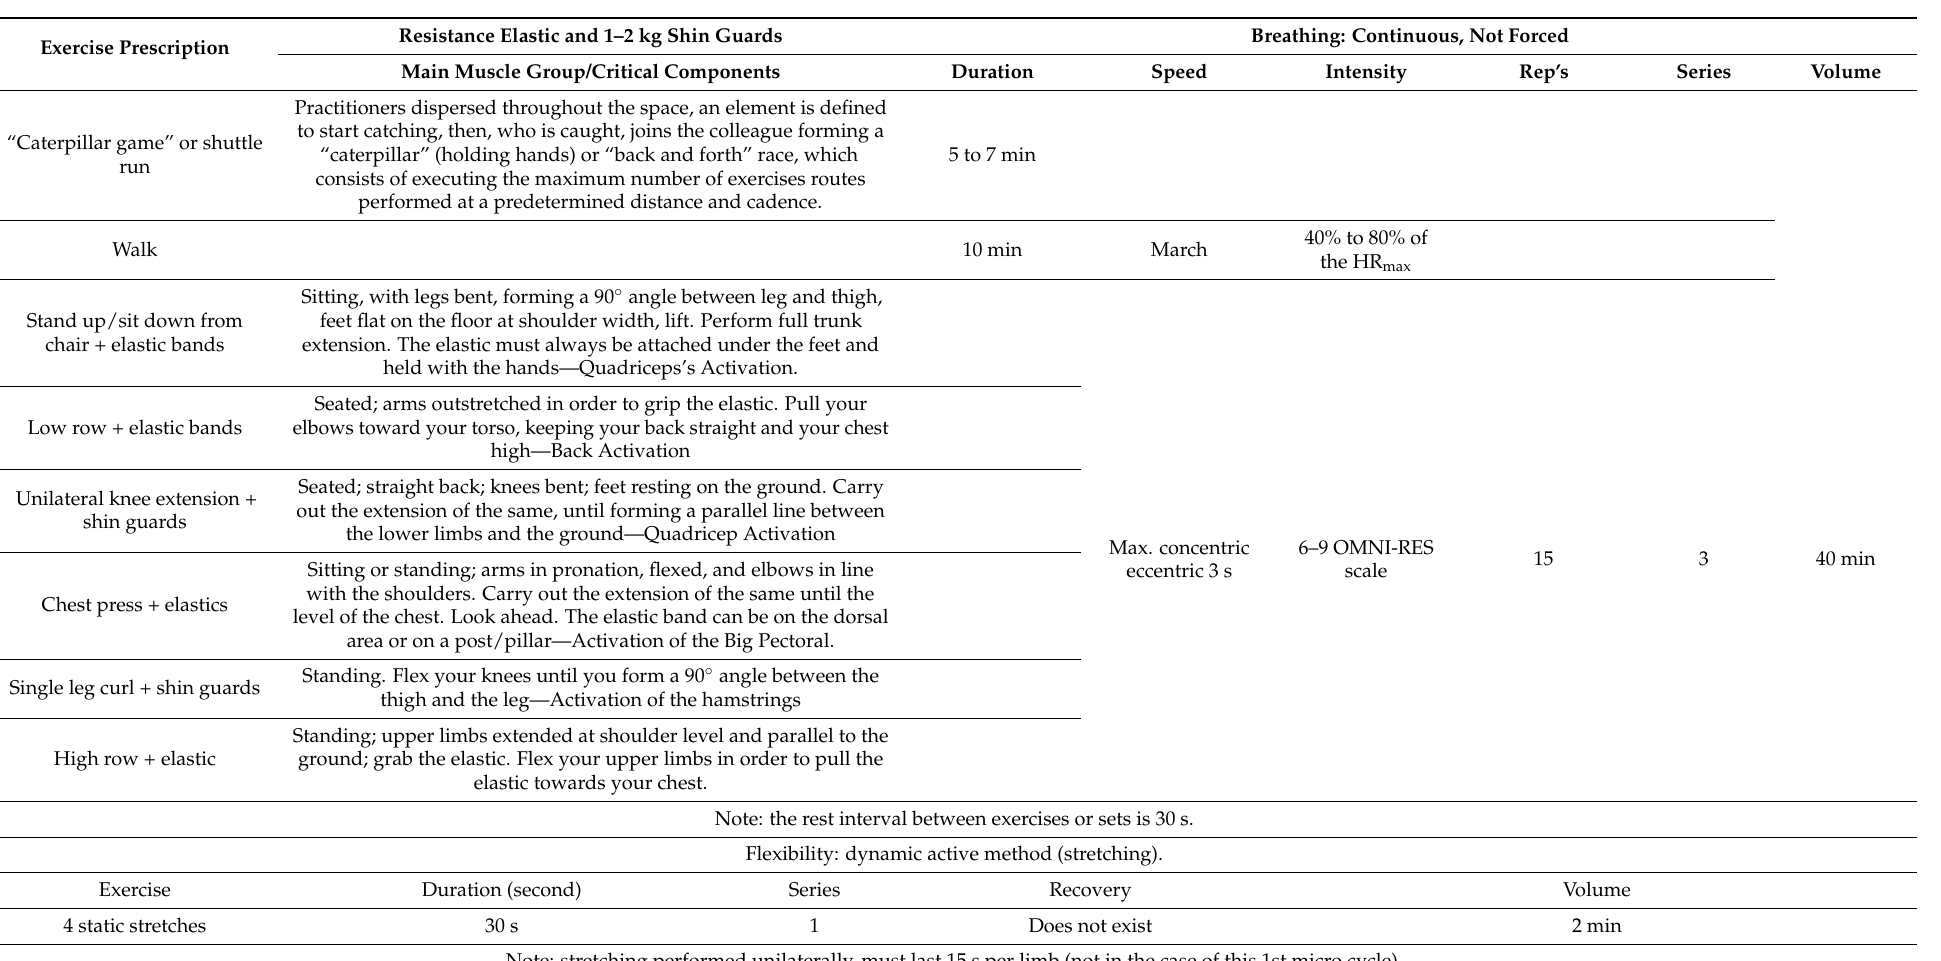
Table 2. Outdoor training